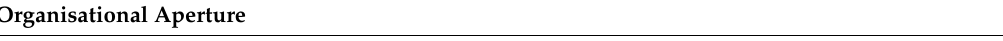
Table 3. Organisational aperture, OI Management, and intellectual property rights (IPR) Protection survey